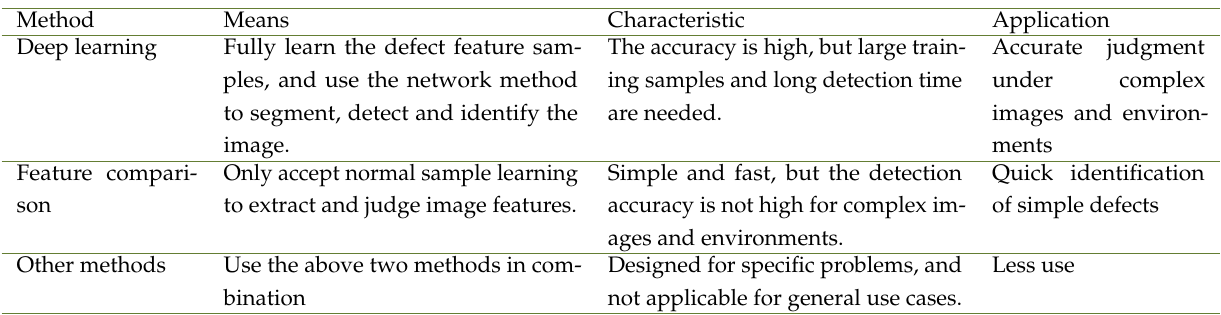
Table 1. Comparison of time performance and performance with different superpixel